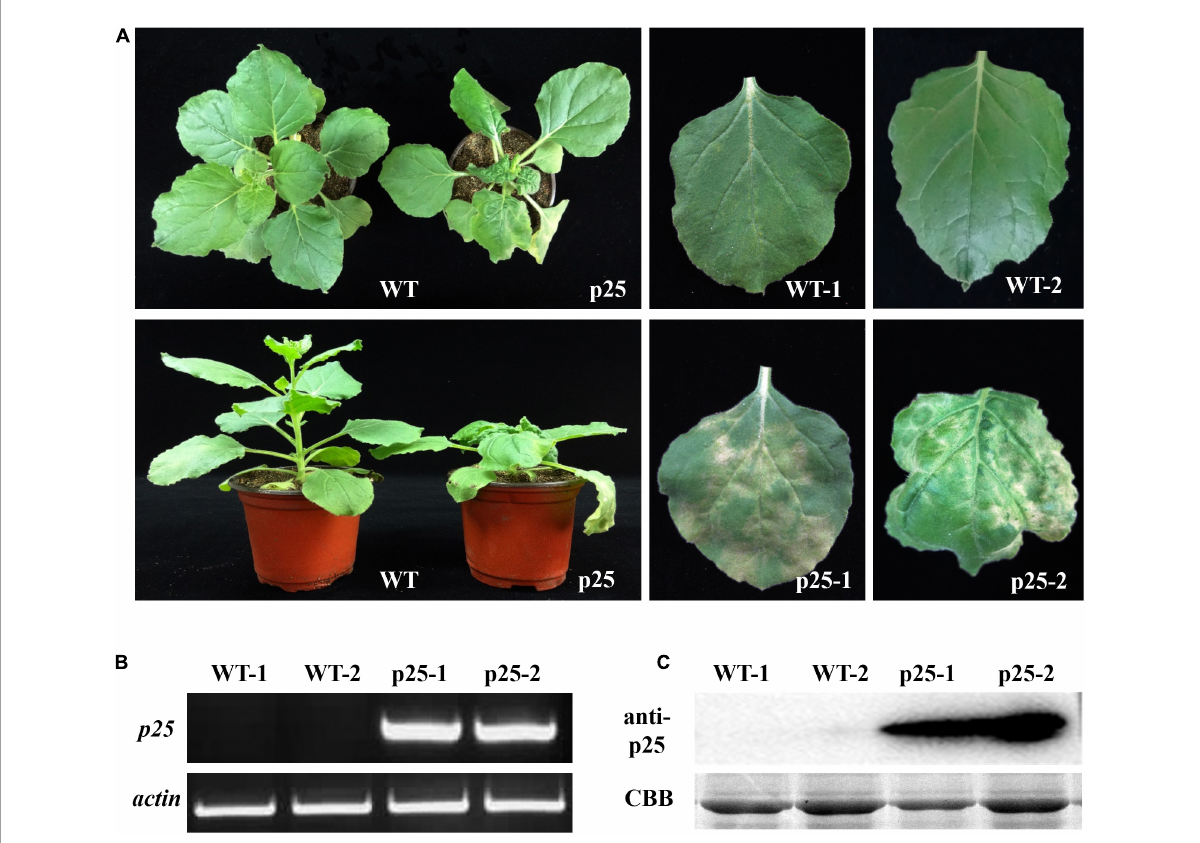
FIGURE2 Maize chlorotic mottle virus (MCMV) p25 is required for viral pathogenicity and systemic movement in TMV MP-transgenic plants of Nicotiana benthamiana . (A) Phenotypes of transgenic plants after inoculation with TMV-p25 and TMVcp-GFP (WT) at 15 days post-inoculation. (B) RT-PCR analysis of RNA from leaves of plants after the two treatments. Actin from N. benthamiana was used as an internal standard. (C) Western blot detection of p25 from the leaves of plants in the two treatments. An anti-p25 antibody was used. Coomassie brilliant blue-stained Rubisco protein (CBB) was used as a total protein loading control. WT, TMV MP-transgenic plants inoculated with TMVcp-GFP; p25, TMV MP-transgenic plants inoculated with TMV-p25. 1, inoculated leaves (WT or p25); 2, non-inoculated leaves on the same plant.